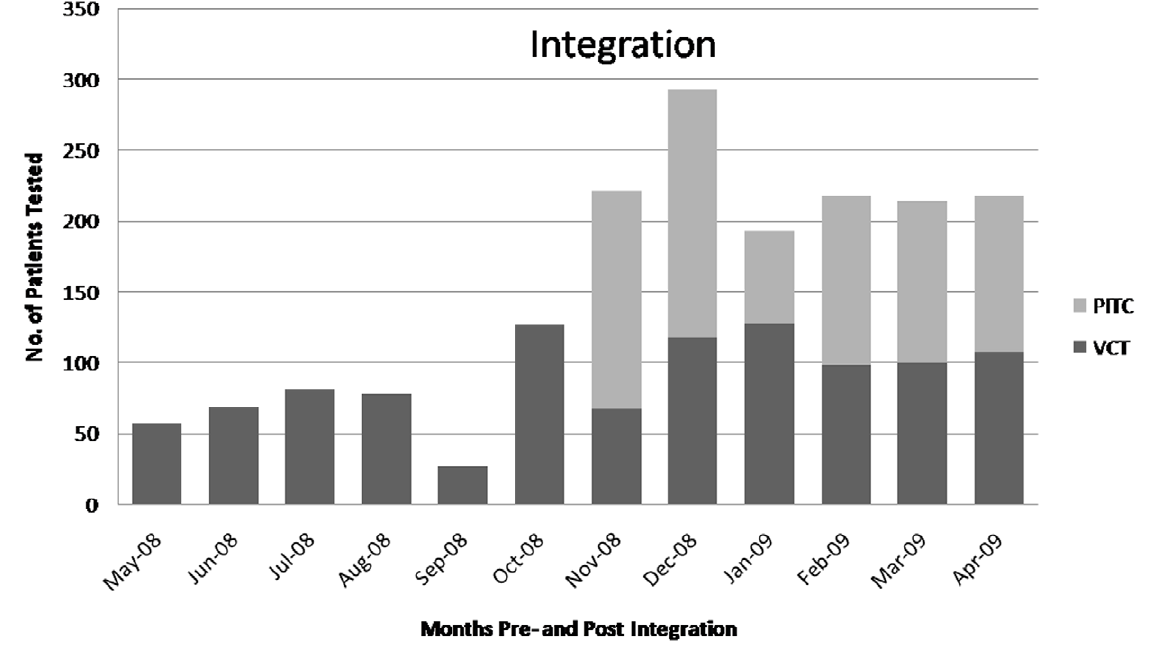
Figure 3. Clinic 2 testing pre- and post-integration.